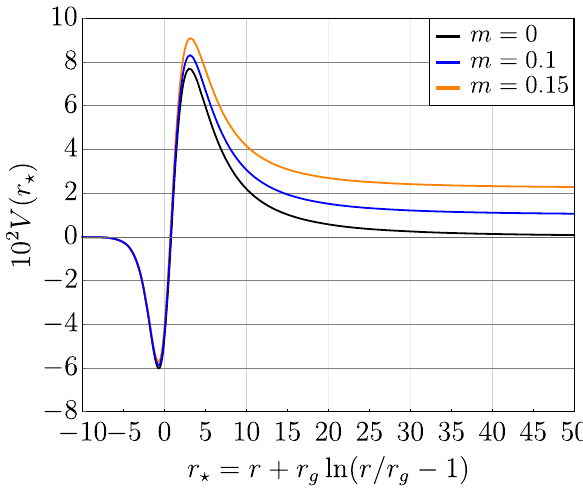
Fig. 2 The effective potential (22) as a function of r (cid:14) for r g = 1. The potential is plotted for three values of m indicated in the figure